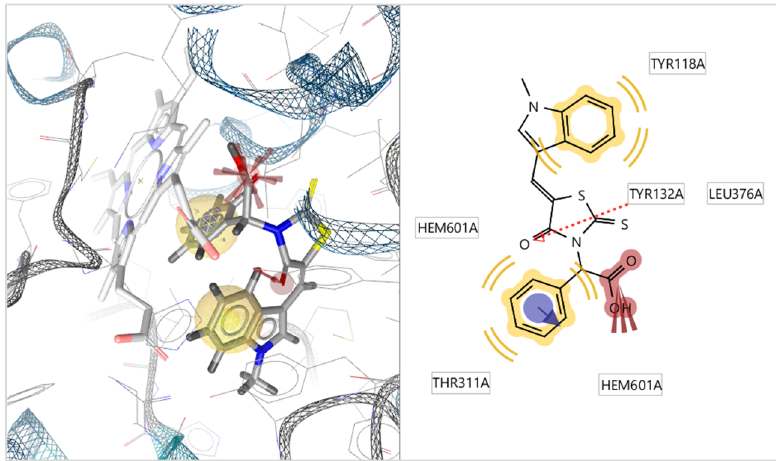
Figure 3. Docked conformation of compound 5f in lanosterol 14α-demethylase of C . albicans (CYP51 ca ).